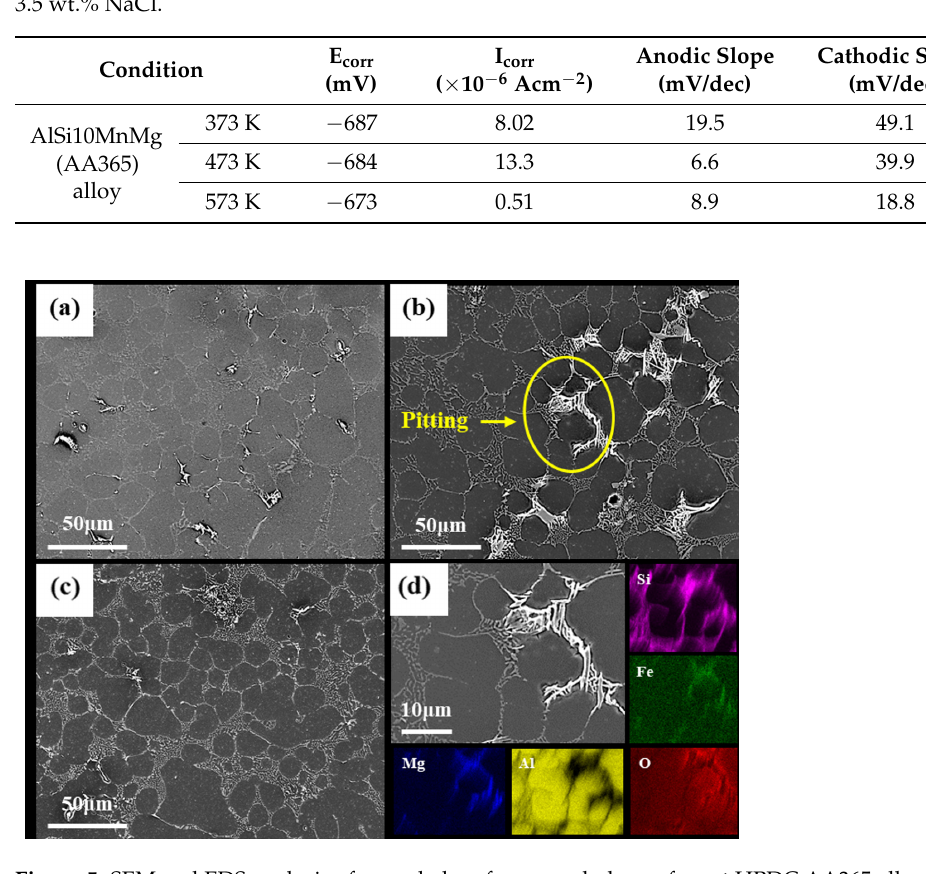
Figure 5. SEM and EDS analysis of corroded surface morphology of crept HPDC AA365 alloys of the attack after electro- chemical testing in 3.5 wt.% NaCl: ( a ) crept HPDC AA365 alloy at 373 K; ( b ) crept HPDC AA365 alloy at 473 K; ( c ) BSE image of crept HPDC AA365 alloy at 473K along with the EDS elemental maps of Al, Si, Fe, Mg, and O; ( d ) crept HPDC AA365 alloy at 573 K